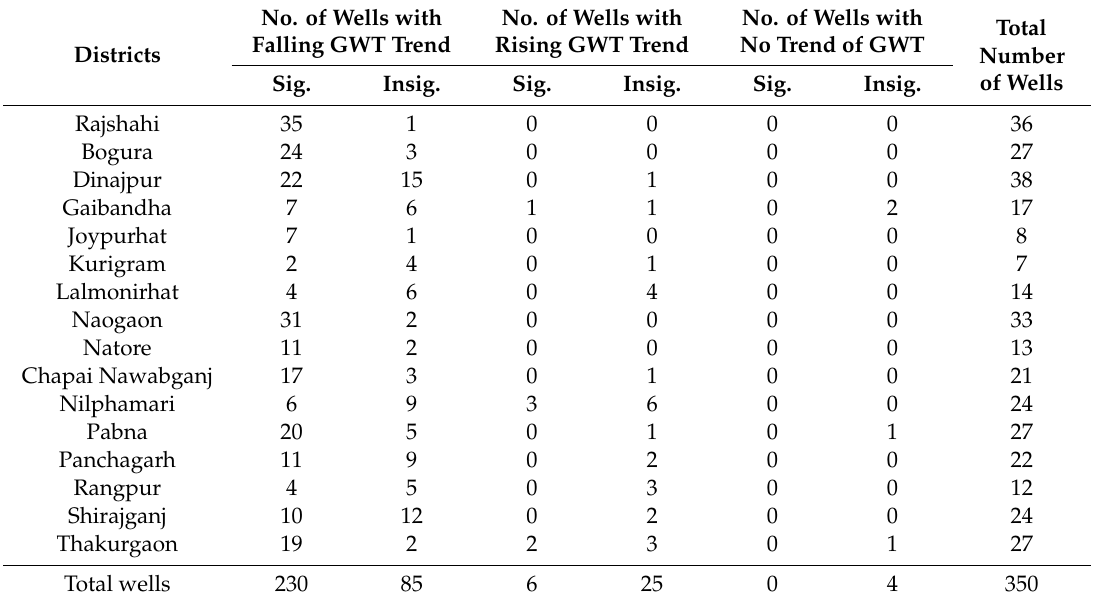
Pabna Panchagarh Rangpur Shirajganj